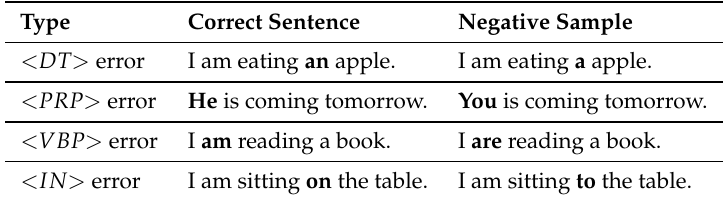
Table 4. Examples of Tag-specific Errors.